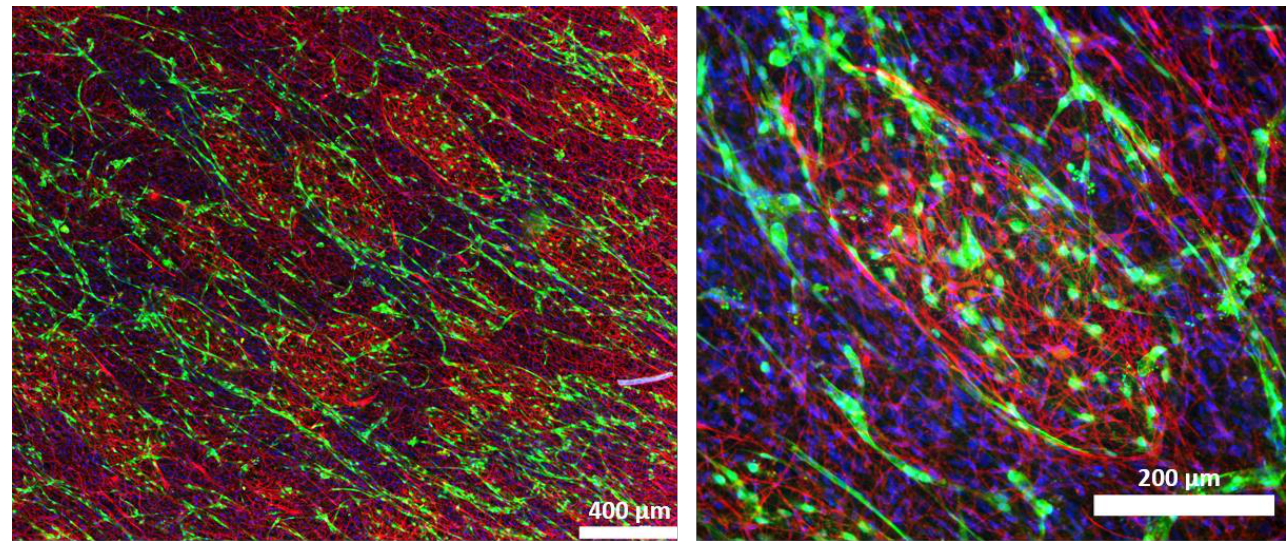
Figure 6. Schwann cells (red) assemble into islands, which are surrounded by lymphatic vessels (green) in co-cultures of LECs, ASCs, and SCs. Green — YFP-LECs, red — SCs stained against S100, blue — cell nuclei.